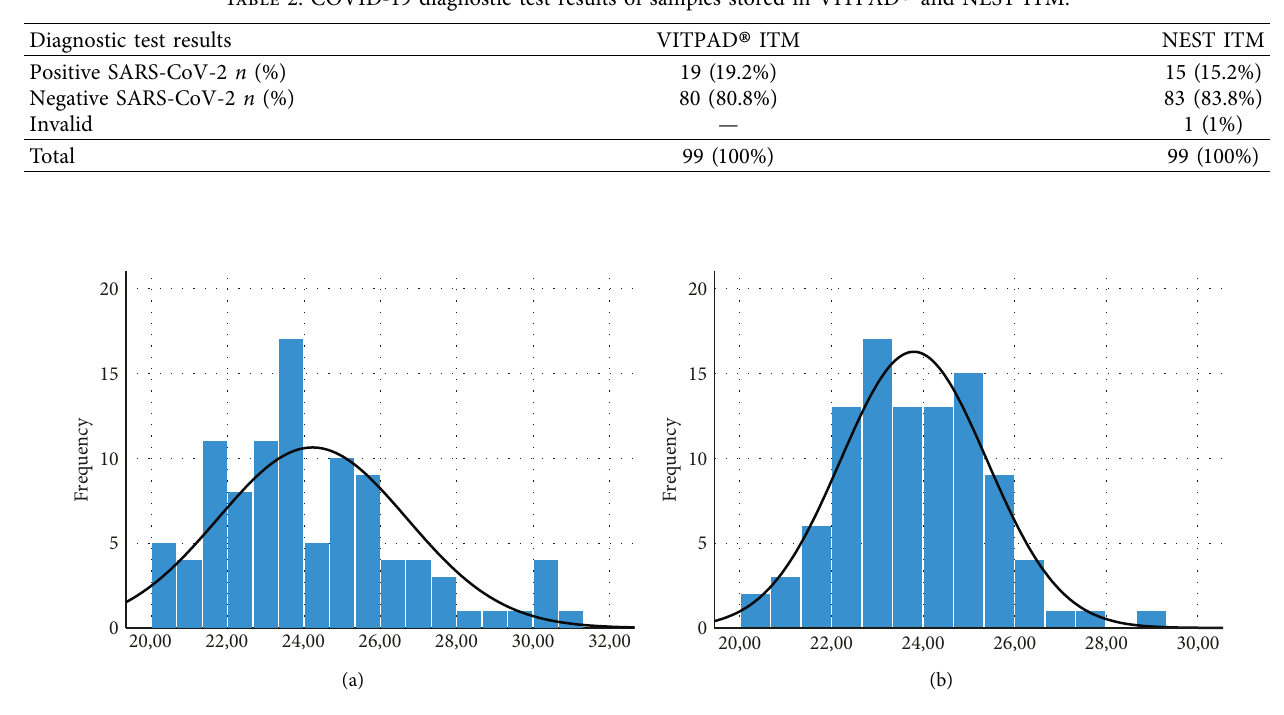
Figure 1: Calculation of the internal control cycle threshold value (IC CT value) of the Sansure reagent. (a) Samples stored in VITPAD ® ITM: mean IC CT value � 24.22, standard deviation � 2.476, and number of sample � 99; (b) samples stored in NEST ITM mean IC CT value � 23.80, standard deviation � 1.601, and number of sample � 98.